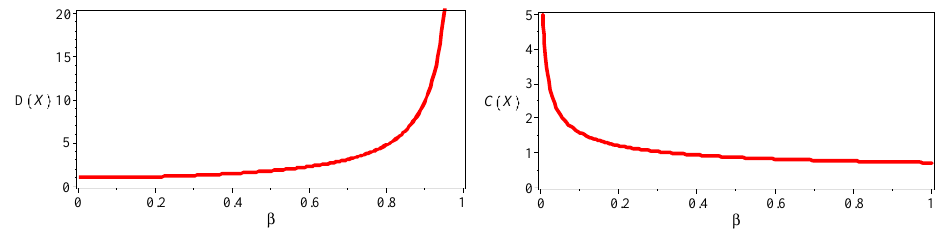
Figure 4 . The plots of D ( X ) and C ( X ) statistics of the DMEx distribution. Figure 4. Plots of the D ( X ) and C ( X ) statistics of the DMEx